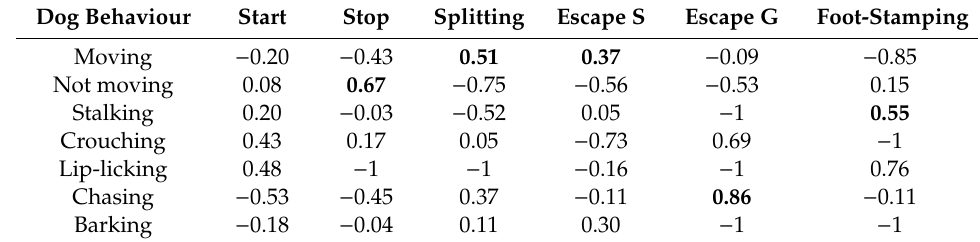
Table A6. Yule’s Q for Event-based dog-initiated sequential behaviour paired interactions.